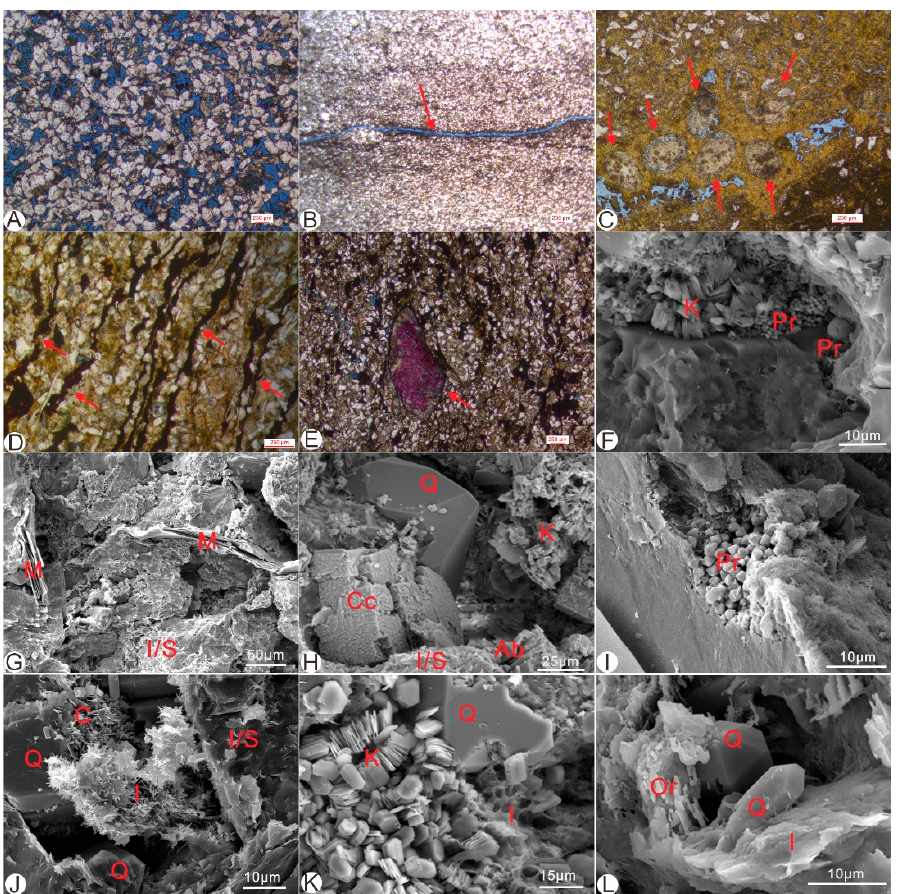
Figure 5. Thin section and SEM images providing information about the mineral composition of beach-bar sandstones in Weixinan sag. ( A ) Well W5, 2610.20 m, high content of quartz and porosity (polarized light). ( B ) Well W5, 2604.38 m, micro-fractures in beach-bar reservoir (polarized light). ( C ) Well W5, 2603.20 m, carbonate oolites (polarized light). ( D ) Well W5, 2612.56 m, black banded carbonaceous fragments (polarized light). ( E ) Well W5, 2605.71 m, carbonaceous fragments and dissolution of detrital grains (polarized light). ( F ) Well W6, 2435.90 m, booklet-like kaolinite and pyrite framboids (SEM). ( G ) Well W1, 3327.04 m, deformation of mica and hairy illite-smectite mixed layers (SEM). ( H ) Well W13, 2266.80 m, authigenic carbonate cement, quartz, booklet-like kaolinite and partly dissolved albite (SEM). ( I ) Well W1, 3331.35 m, octahedral pyrites (SEM). ( J ) Well W1, 3334.50 m, fibrous illite, quartz and flaky illite-smectite mixed layers (SEM). ( K ) Well W12, 2755.82 m, booklet-like kaolinite, quartz and honeycombed illite (SEM). ( L ) Well W12, 2699.52 m, quartz and partly dissolved orthoclase (SEM). Ab—albite, Cc—carbonate cement, I—illite, I/S-illite and smectite mixed layer, K—kaolinite, M—mica, Or—orthoclase. Pr—pyrite, Q—quartz.